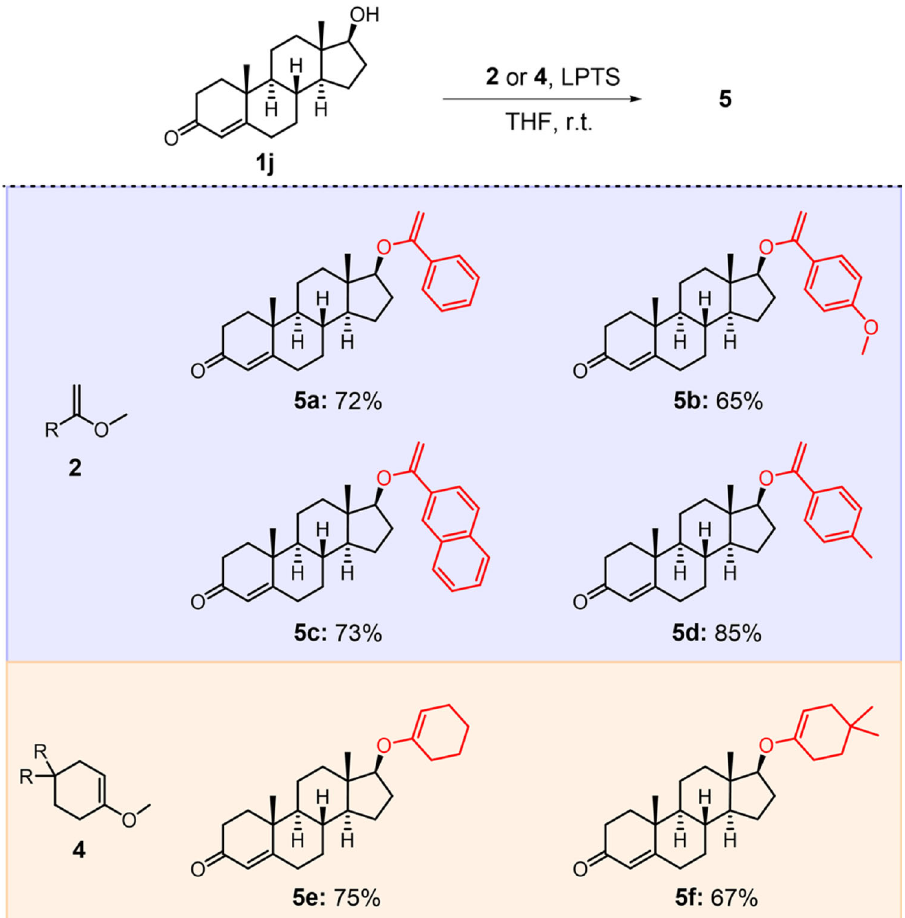
Fig. 3 Synthetic scope of enol ethers a . a Reaction conditions: 1j (1.0 equiv.), 2 or 4 (16.0 equiv.), 20.0 mol % LPTS, THF, 25 o C, 24 h. Yields of isolated products are